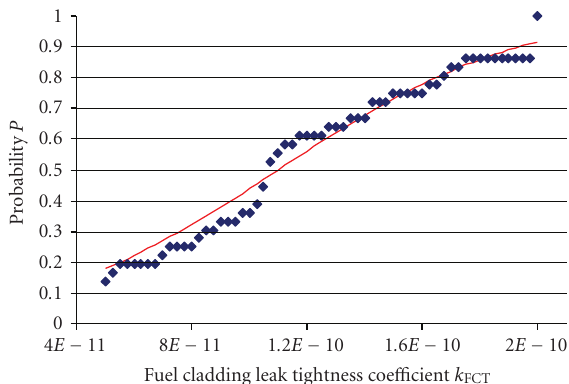
Figure 2: Distribution function of continuous variable k FCT